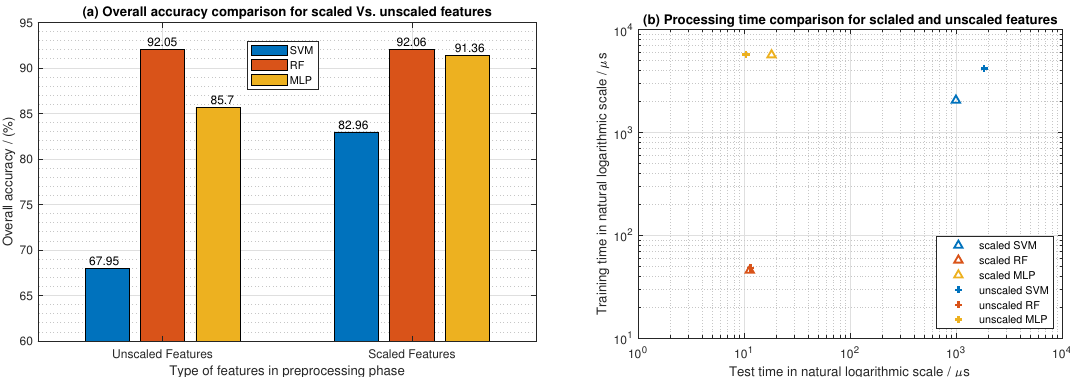
Figure 6. Comparison of the overall accuracy, training, and test times for the scaled vs. unscaled features in the preprocessing phase. ( a ) Overall accuracy comparison for scaled Vs. unscaled features ( b ) Processing time comparison for scaled and unscaled